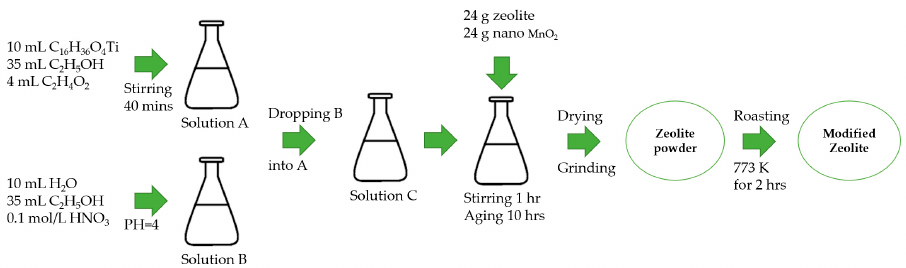
Figure 2. Mn-Ti modified zeolite preparation schematic.